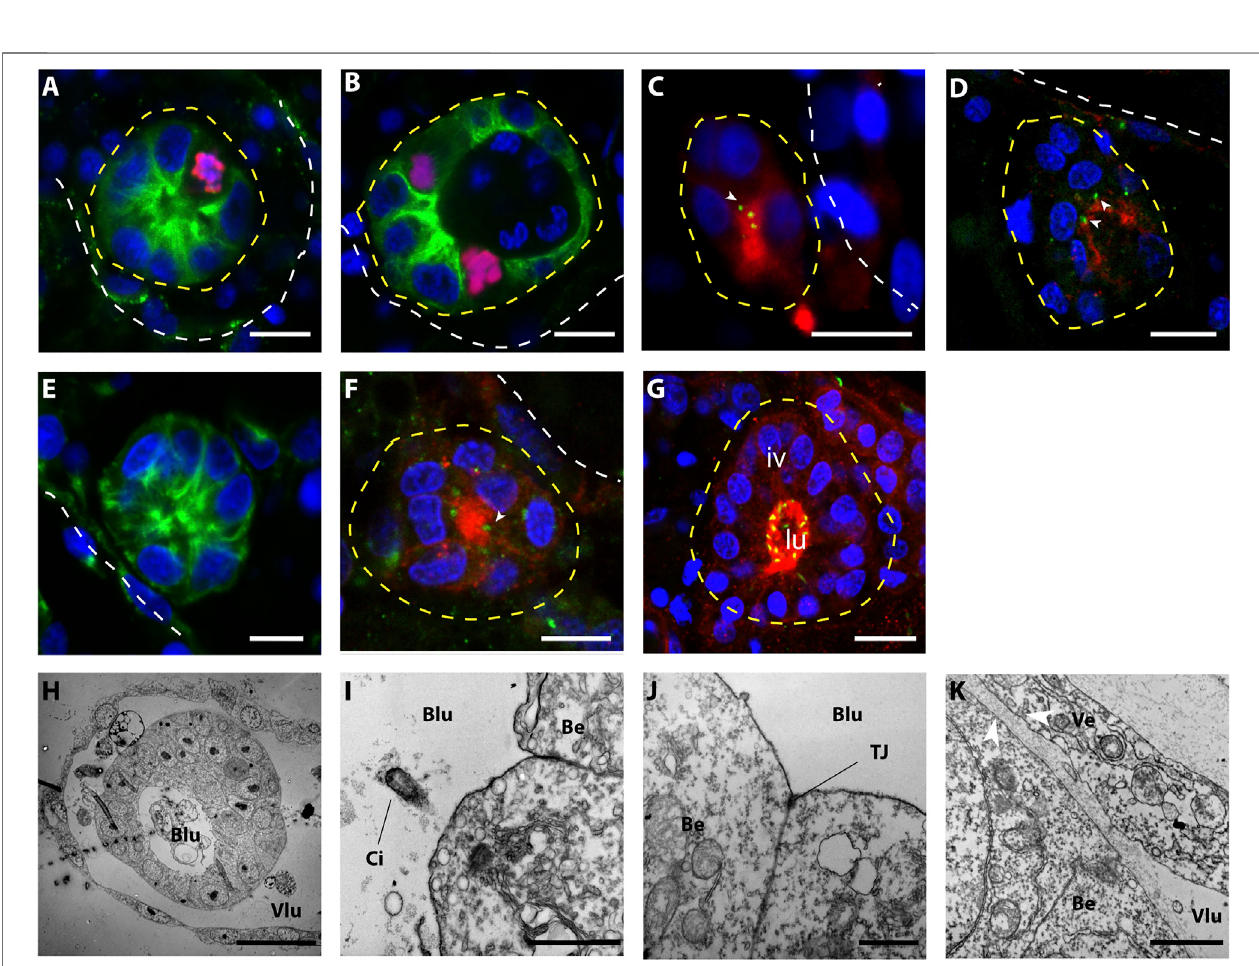
FIGURE2| S8showingtissueleft-overfusingwiththevasculatureatthedoublevesiclestage,from (L) 0 hpito (M) 7 hpi, (N) 20 hpi,and (O) 40 hpi. (J – K ’’ ) Microscopic view of the areas squared in (O) . (P) Transmitted light, the double monolayer vesicle can be seen engulfed by the vasculature. (Q) Hoechst staining. (Q 9 ) Acetylated tubulin counter-staining. (Q ’’ ) Composite. (R – T) Screenshots from Supplementary Movie S9 showing tissue left-over fusing with the vasculature from (R) 0 hpi to (S) 19 hpi and (T) 22 hpi. (U – U ’’ ) Microscopic view of the areas squared in (T) . (U) Hoechst staining. (U 9 ) Acetylated tubulin counter-staining. (U ’’’ ) Orthogonal projections of the confocal stack show the histological continuity between the bud epithelium and the vascular wall. White arrowheads: tissue left-over, red arrowheads: ampullae fusing with the bud, yellow arrowheads: fusion between bud and vascular epithelium, asterisk: neighboring ampulla.